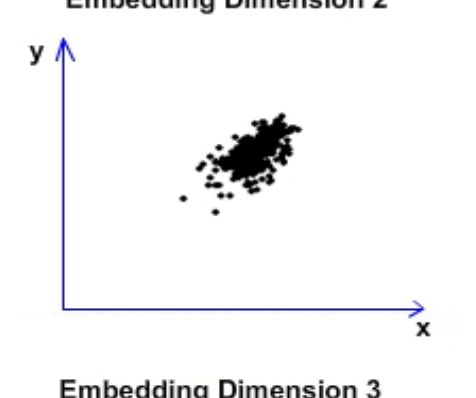
Figure 13. The selection of a normal area.